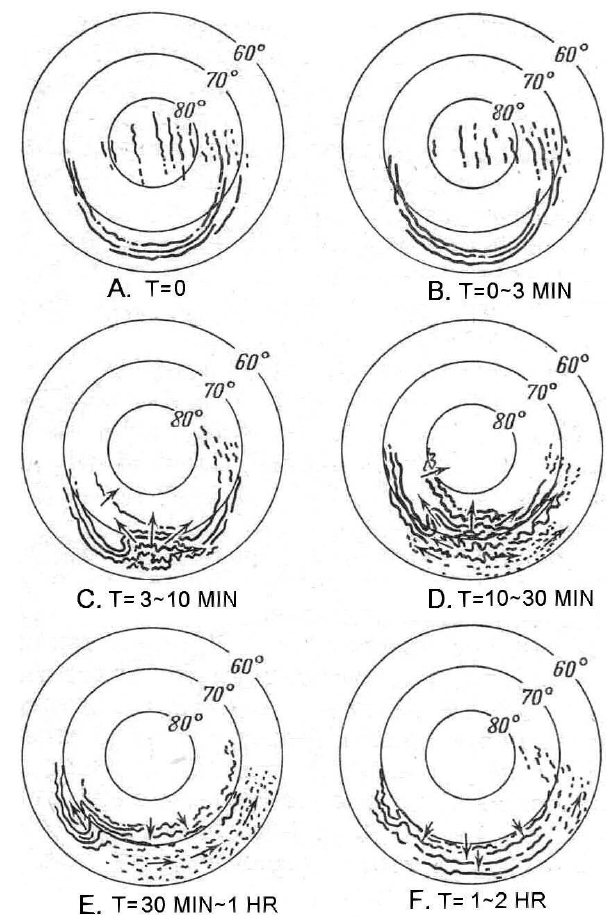
Figure 20. Schematic diagram of substorm development for night- time aurorae (Akasofu,